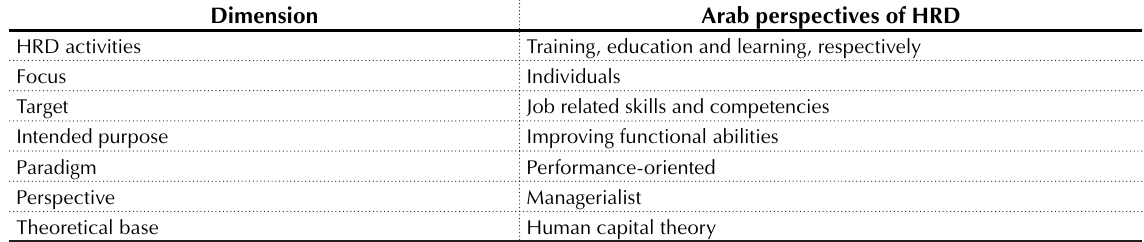
Table 1. HRD in Arab